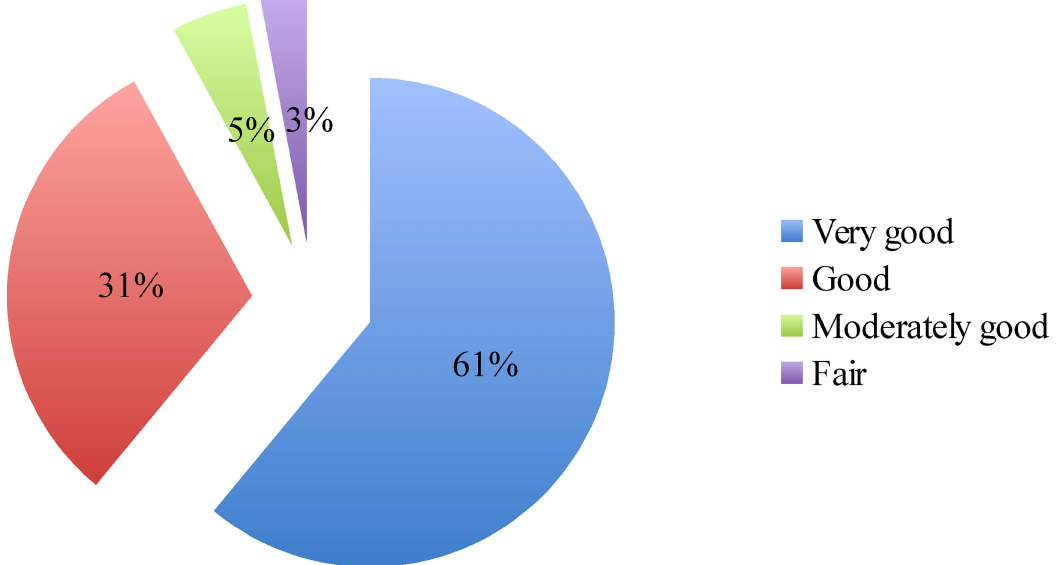
Fig 1. Distribution of the overall patient satisfaction with PMTCT services. Color fill represents levels of dissatisfaction as rated by patients; blue represents “very good", brown represents “good, green represents “moderately good" and purple represents “fair"